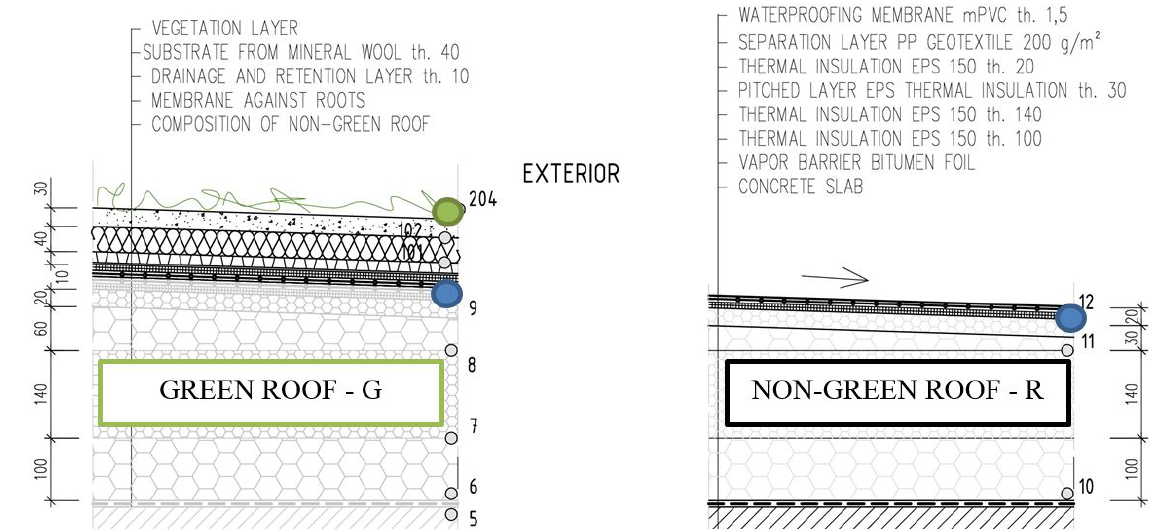
Figure 5. Detail of compared roof compositions with installed sensors – color-marked ones are used in the results graphs.